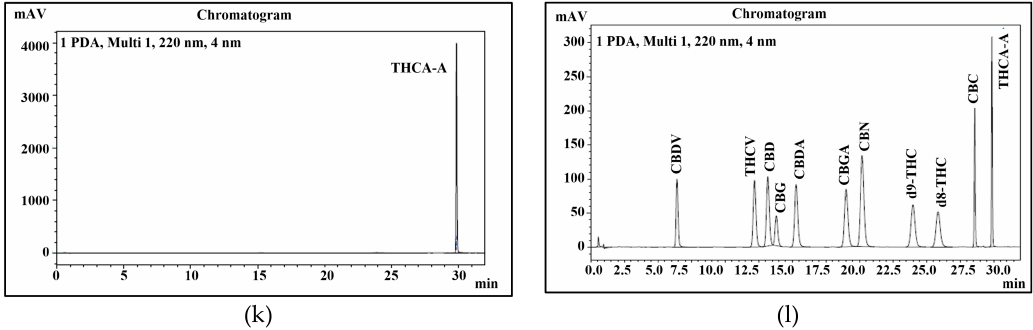
Figure 10. Peaks identification of eleven cannabinoids. ( a ) uHPLC profile of CBDV; ( b ) uHPLC profile of THCV; ( c ) uHPLC profile of CBD; ( d ) uHPLC profile of CBG; ( e ) uHPLC profile of CBDA; ( f ) uHPLC profile of CBGA; ( g ) uHPLC profile of CBN; ( h ) uHPLC profile of Δ 9 -THC; ( i ) uHPLC profile of Δ 8 -THC; ( j ) uHPLC profile of CBC; ( k ) uHPLC profile of THCA-A; ( l ) uHPLC profile of 11 cannabinoid mixture. Table 2. System suitability for higher concentration (20 µg/mL) of 11 cannabinoid standard mixtures. Name of Cannabinoid